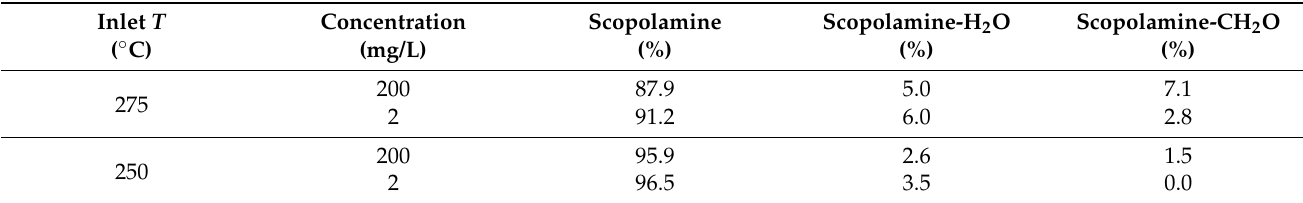
Table 2. Influence of inlet temperature and concentration on the ratio between scopolamine and its degradation products in ethyl acetate presented as percentage of a sum of